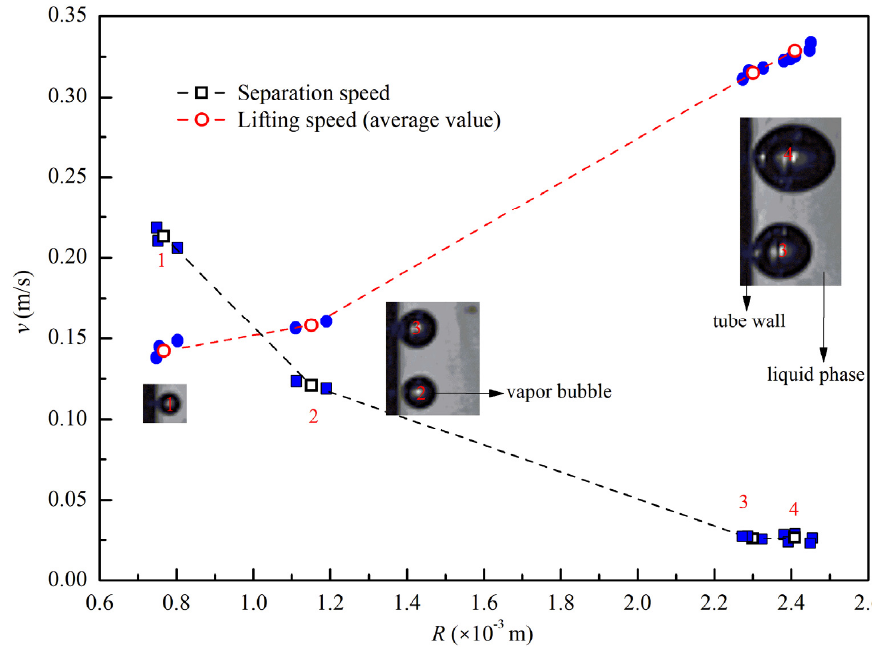
Figure 8. Buoyancy and separation velocity of bubbles.